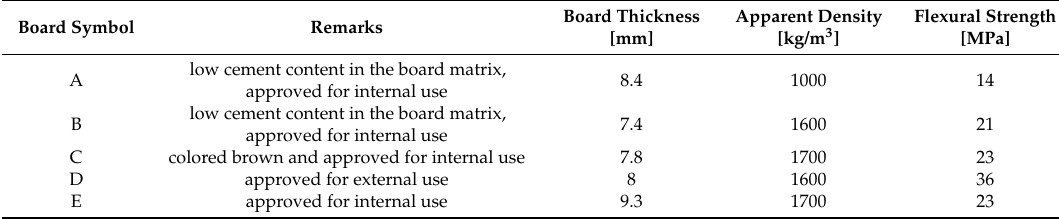
Table 1. Mechanical properties of the tested FCB